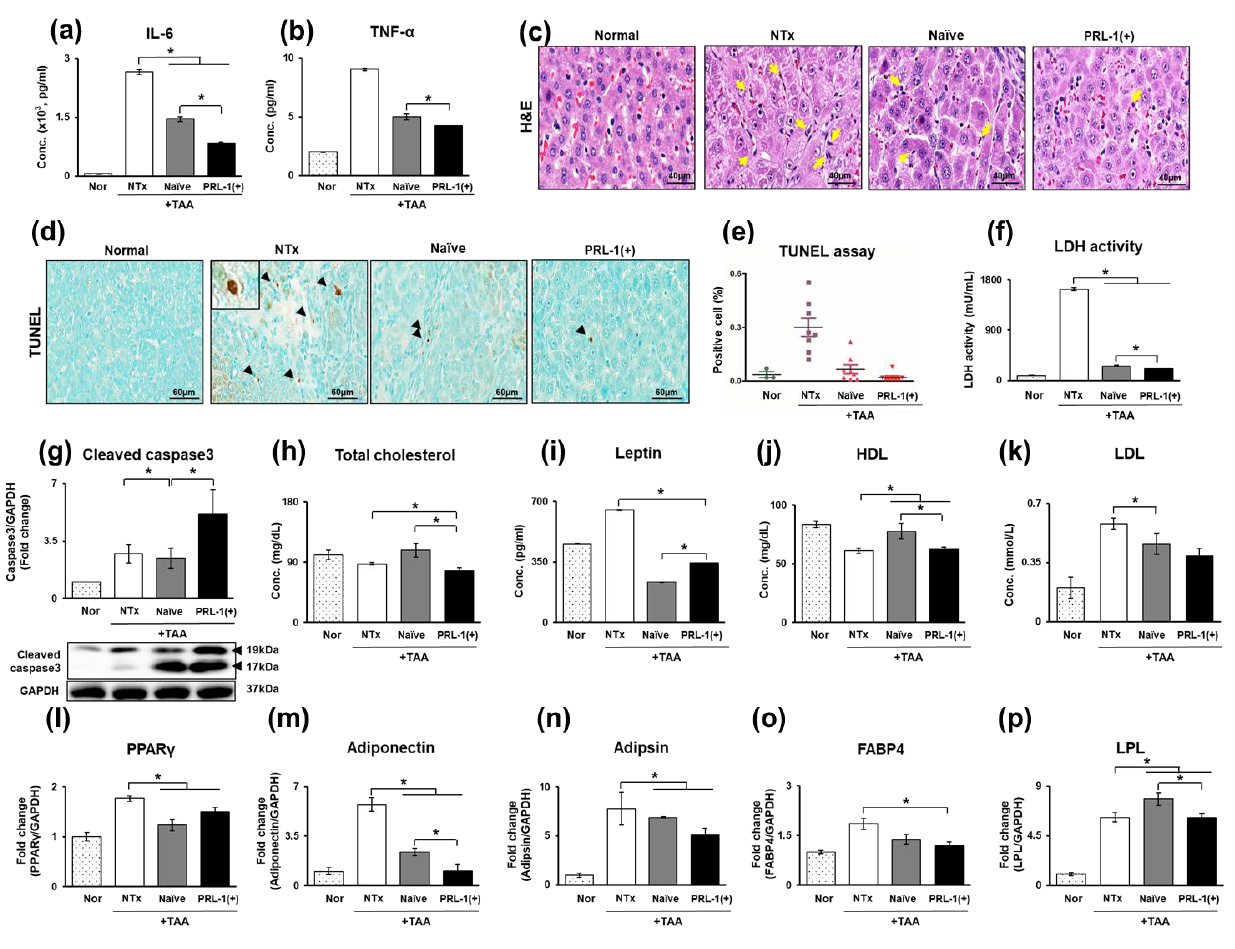
Figure 1. Effect of naïve and PRL-1(+) cells on apoptosis in TAA-injured rat livers. The expression of inflammation and apoptosis markers in TAA-injured rat livers ( a ) IL-6, ( b ) TNF- α, ( c ) H&E; yellow arrows: apoptotic cells, ( d ), ( e ) TUNEL assay, ( f ) LDH activity, ( g ) cleaved caspase 3. The expression of lipid metabolism markers in the TAA-injured rat model in the serum and via mRNA analysis ( h ) total cholesterol, ( i ) leptin, ( j ) HDL, ( k ) LDL, ( l ) PPARγ, ( m ) adiponectin, ( n ) adipsin, ( o ) FABP4, and ( p ) LPL. All experiments were repeated in duplicate to triplicate. * p < 0.05.